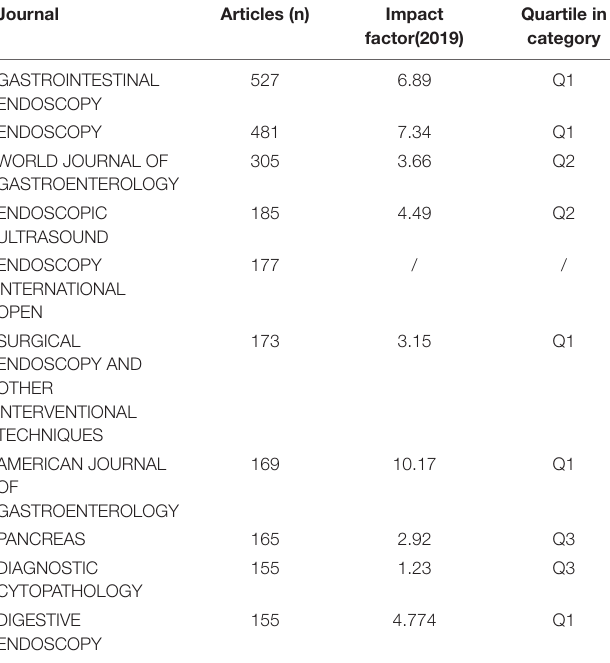
TABLE 3 | The top 10 journal contributed to publications of EUS